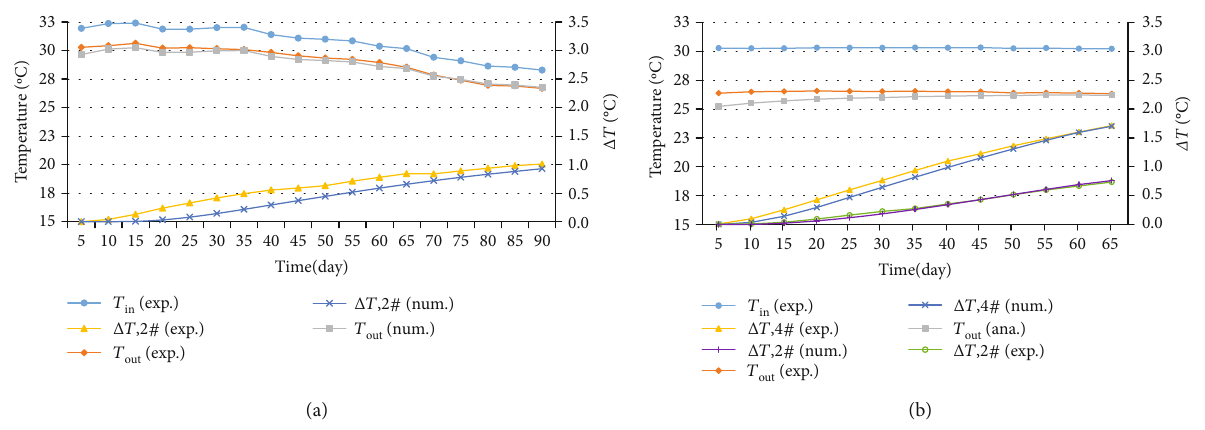
Figure 4: (a) Inlet and outlet temperatures in borehole 2#. (b) Inlet and outlet temperatures in boreholes 2# and 4#. Table 1: Accuracies and measuring ranges of the sensors in the experimental